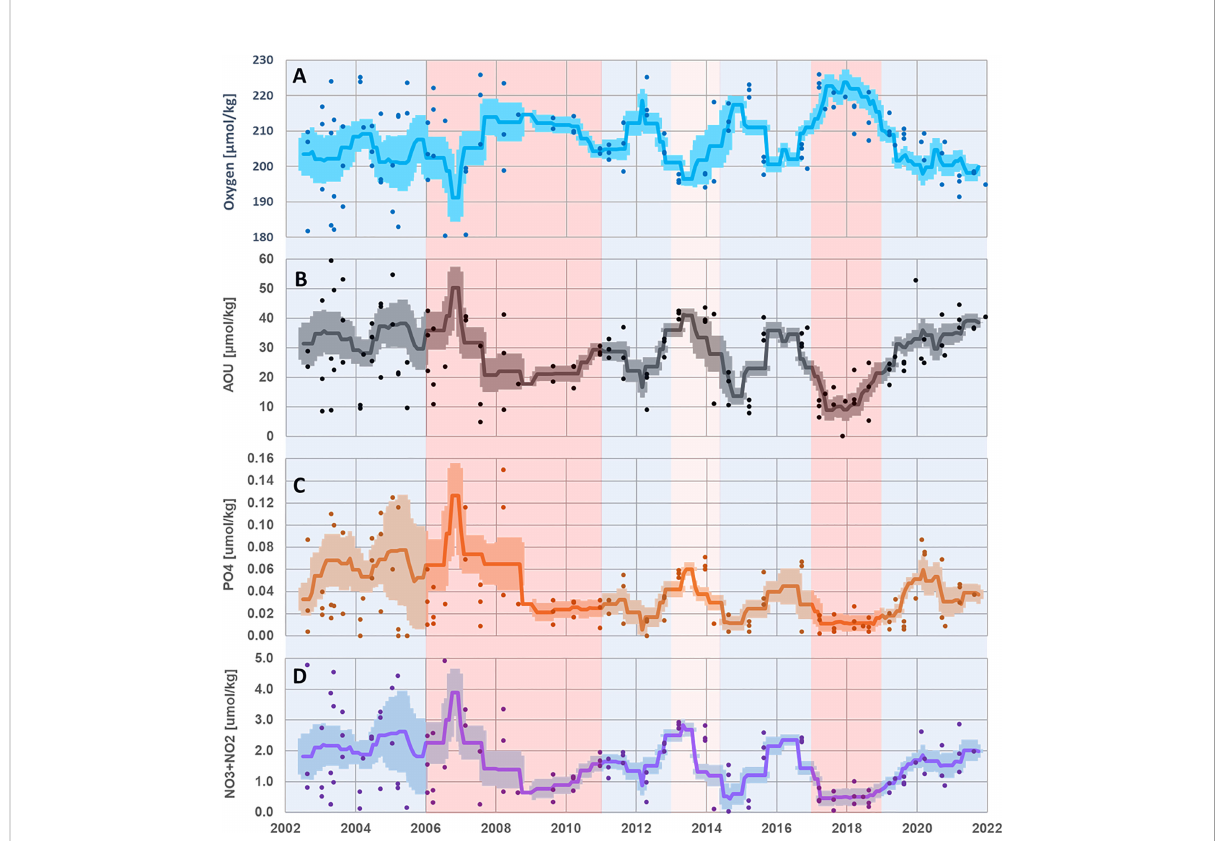
FIGURE 3 Time series of dissolved oxygen ( A ; blue), Apparent oxygen utilization (AOU; B ; black), dissolved PO 4 concentrations ( C ; orange), and dissolved NO 3 +NO 2 concentrations ( D ; purple) were performed in the core of the LIW water mass (ca. 130 m< z< 350 m) during the Haifa Section cruises (2002 – 2021). Station-speci fi c values are presented in dots; the moving average is presented in a solid line, and the standard error ranges are indicated with a light-colored area. Circulation periods are presented as in Figure 2. LIW, Levantine intermediate